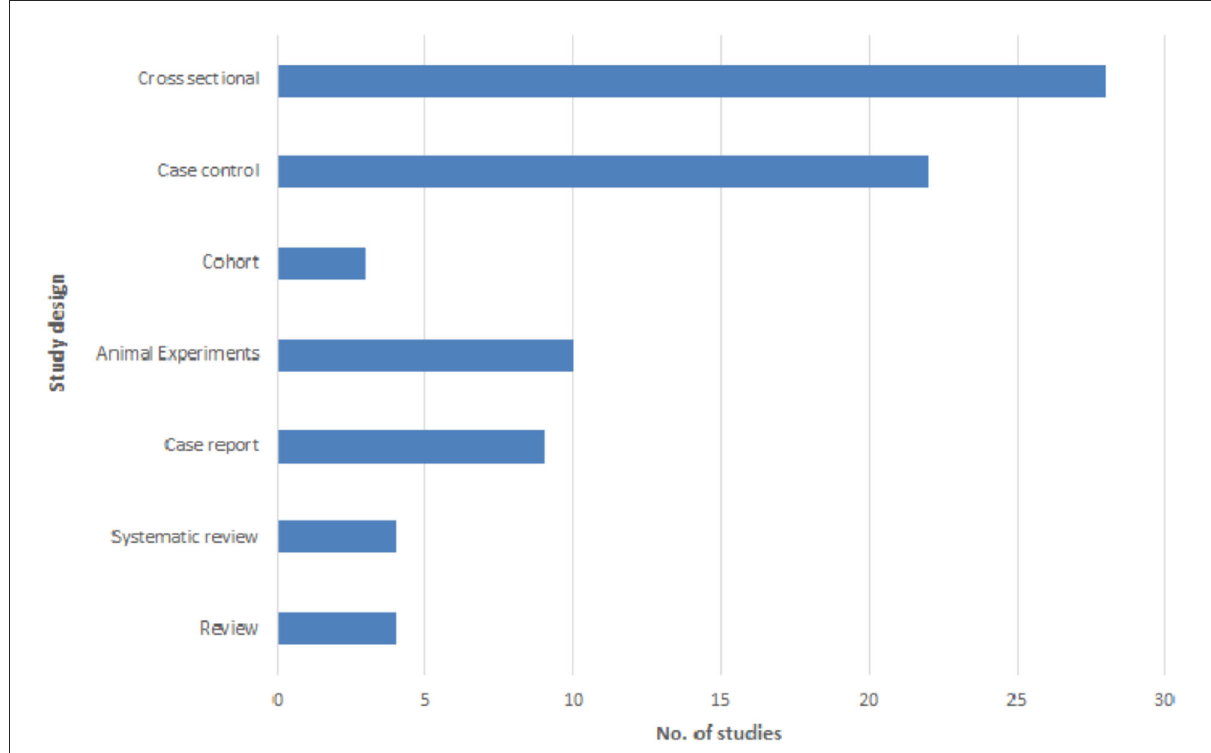
FIGURE3 Frequency distribution of the studies investigating the asthma- Toxocara association according to different study